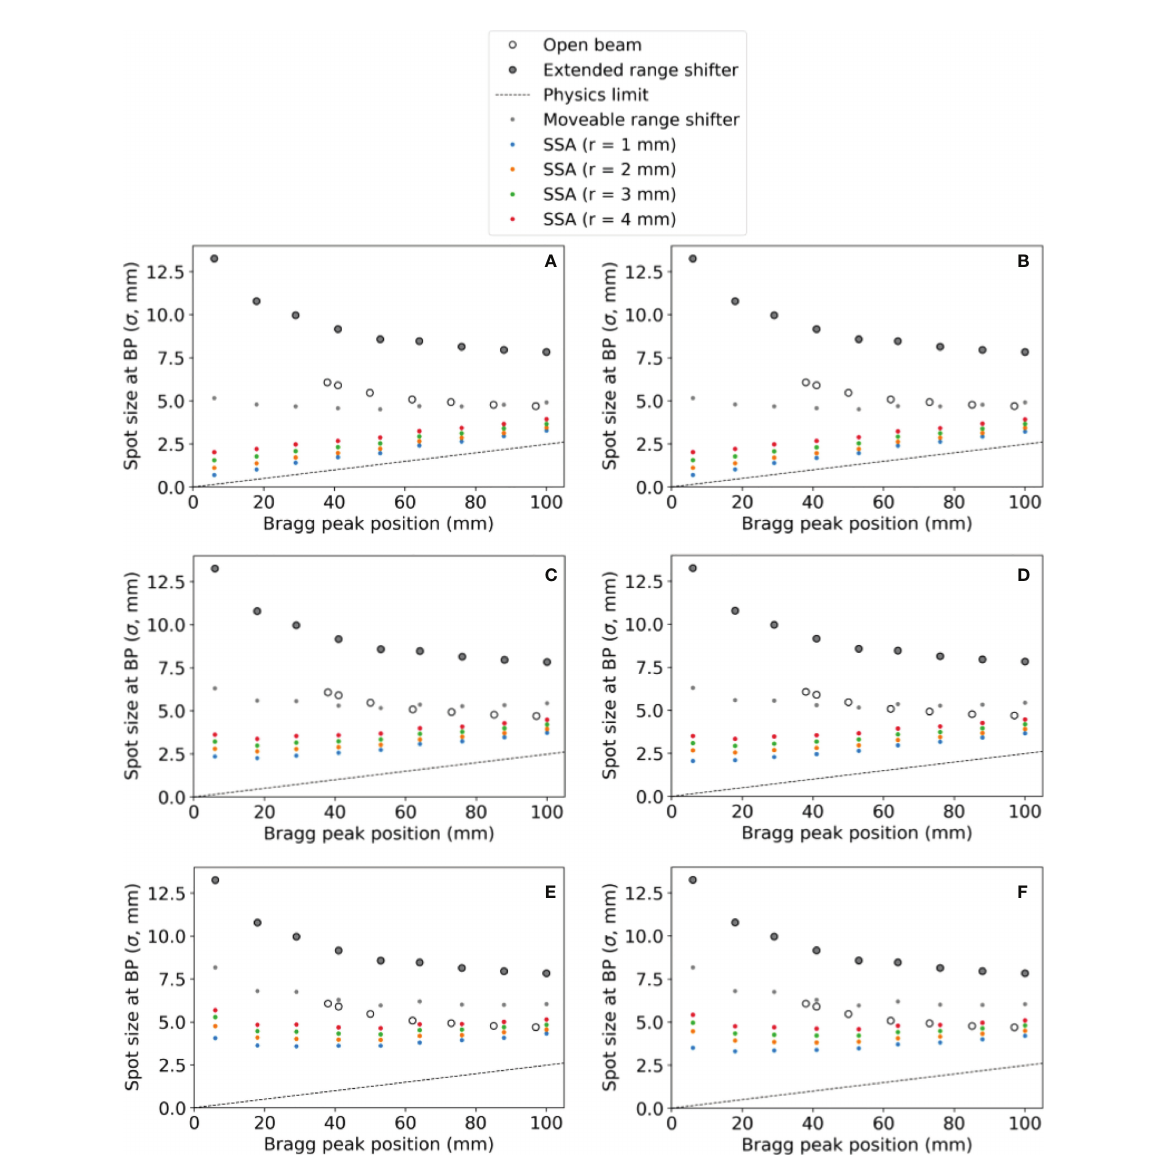
FIGURE 5 The spot sizes at the BP position for different SSA con fi gurations (aperture opening radius and ASDs), for the extended range shifter (ERS), for the open beam, and for a moveable range shifter. Tungsten results are on the left and nickel results are on the right. The aperture distance to the water phantom surface was (A, B) 1 mm, (C, D) 50 mm, (E, F) 100 mm. The radius of the SSA varied from 1 mm to 4 mm as indicated by different colors in the fi